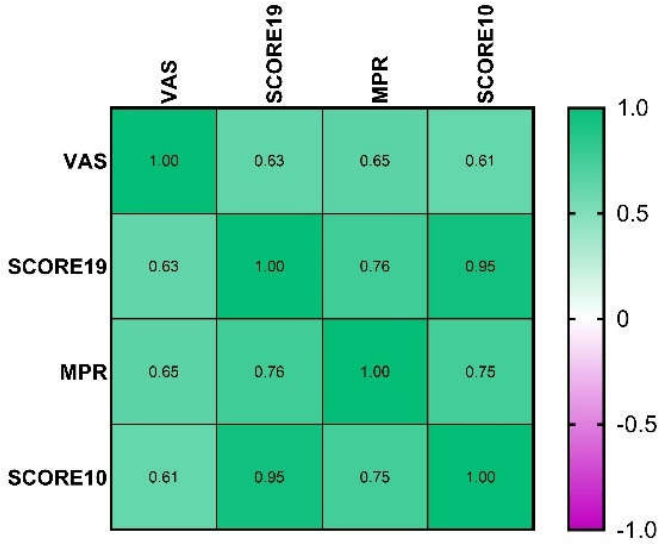
Figure 3. Heatmap containing Spearman coefficients with values from −1 to 1, as the colours from the right show, larger values were represented by dark green and smaller values by dark mauve. SCORE10, the adherence score calculated with HCV-AD10; SCORE19, the adherence score calculated with HCV-AD19.